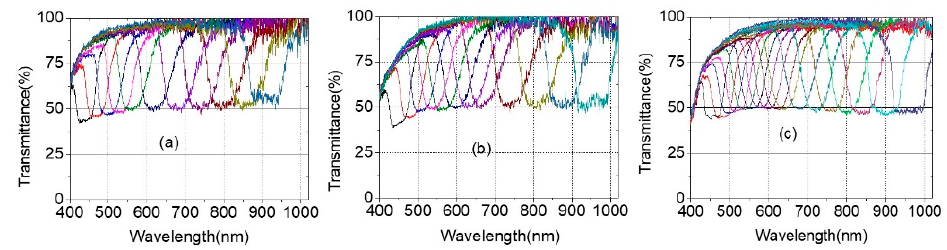
Figure 10. Continuous PBG transmission spectra of R-PCLC1 wedge cell for vertical incident beams in Path 1 of Figure 4. ( a ) PBG data from the newly fabricated cell, ( b ) PBG data after thermal treatment in a 170 °C oven for 1 h, ( c ) PBG data after about two years have elapsed since the thermal treatment in ( b ). Although PBGs could be measured at a high density with a fine spatial movement, data are shown in a low density to distinguish one by one easily.